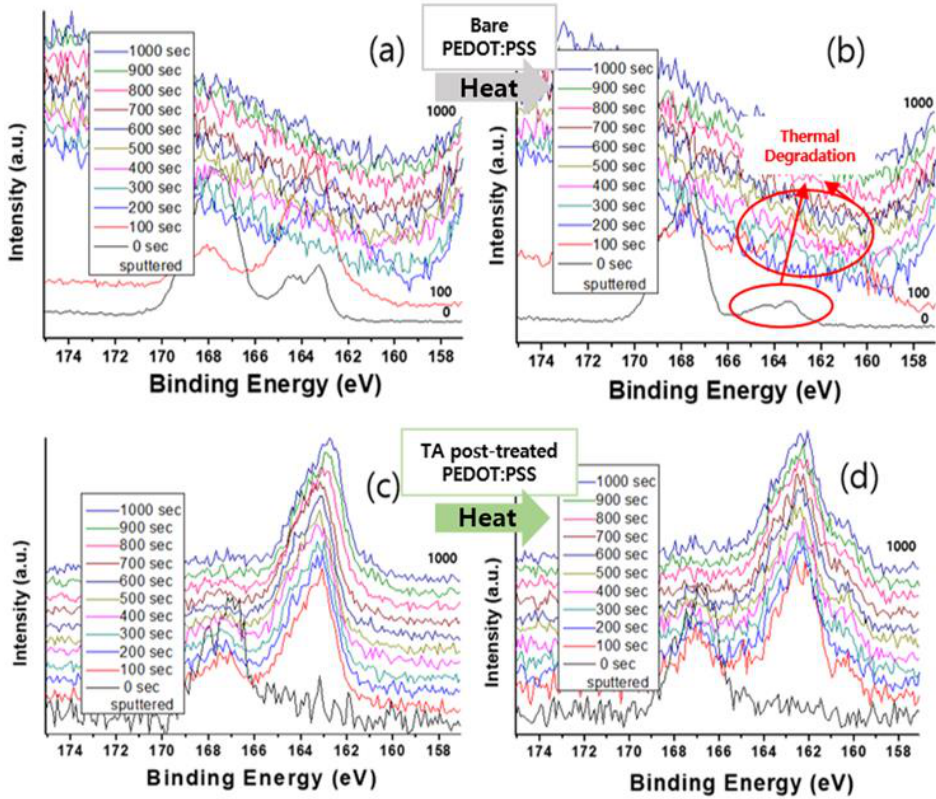
Figure 5. S2p XPS spectra of ( a ) PEDOT:PSS, ( b ) PEDOT:PSS-HT, ( c ) TA-dipped PEDOT:PSS, and ( d ) TA-dipped PEDOT:PSS-HT films. The legends indicate the time since the start of the depth profiling. Zero is equivalent to a standard surface scan.